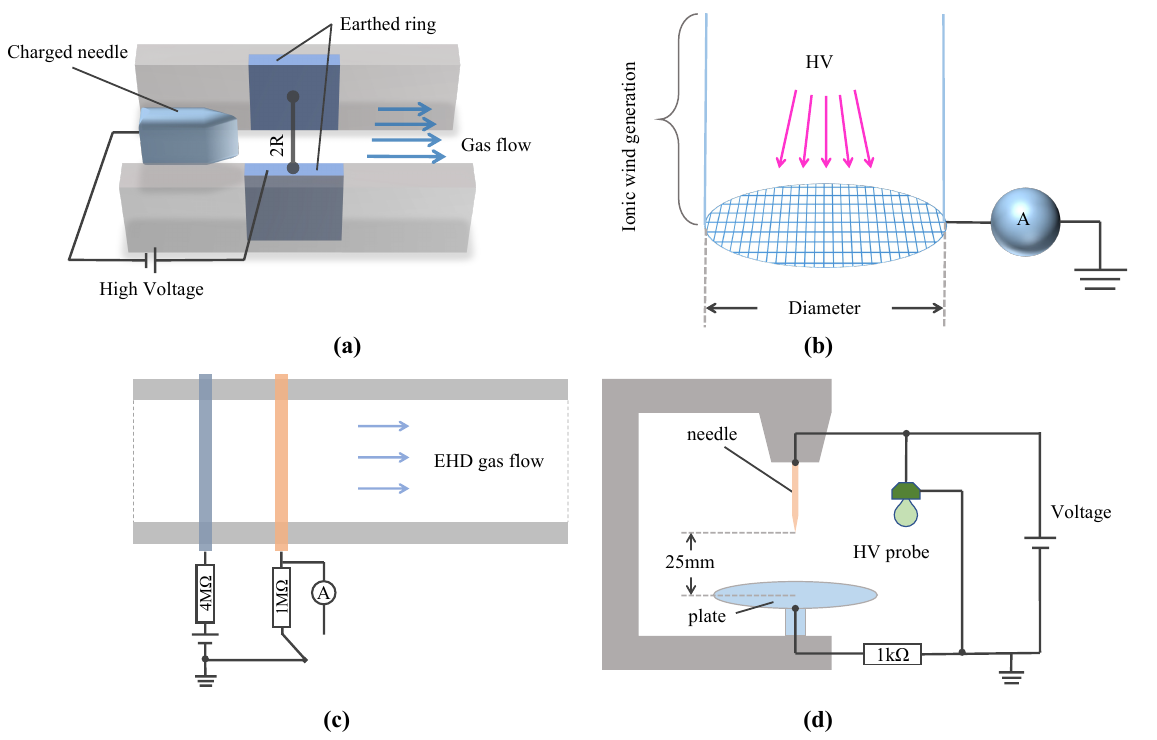
Figure 5. Schematic of EHD gas pump with various electrode types. ( a ) Needle-ring electrodes [73]. ( b ) Mesh-ring electrodes [4]. ( c ) Wire-rod electrodes [74]. ( d ) Needle-plate electrodes